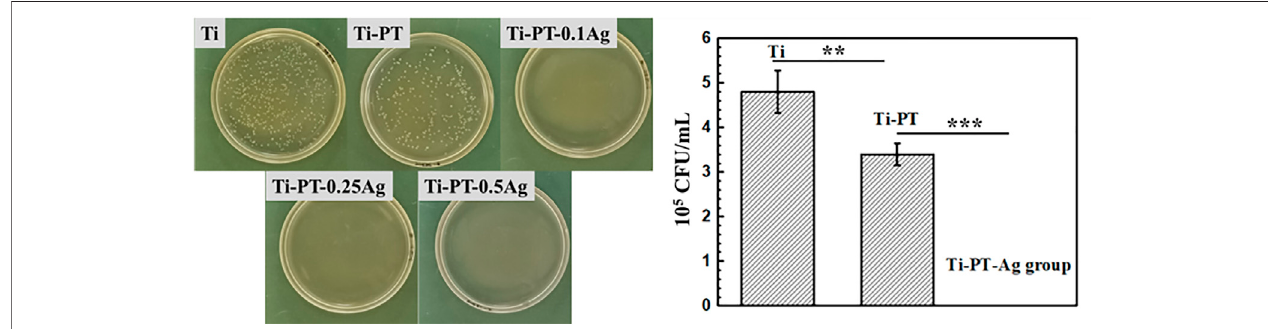
FIGURE 6 | Photographs (left) and the number (right) of E. coli colonies formation on Ti, Ti-PT, Ti-P-0.1Ag, Ti-PT-0.25Ag, and Ti-PT-0.5Ag. Data are presented as mean ± SD and analyzed by one-way ANOVA (** p < 0.01, *** p < 0.001).